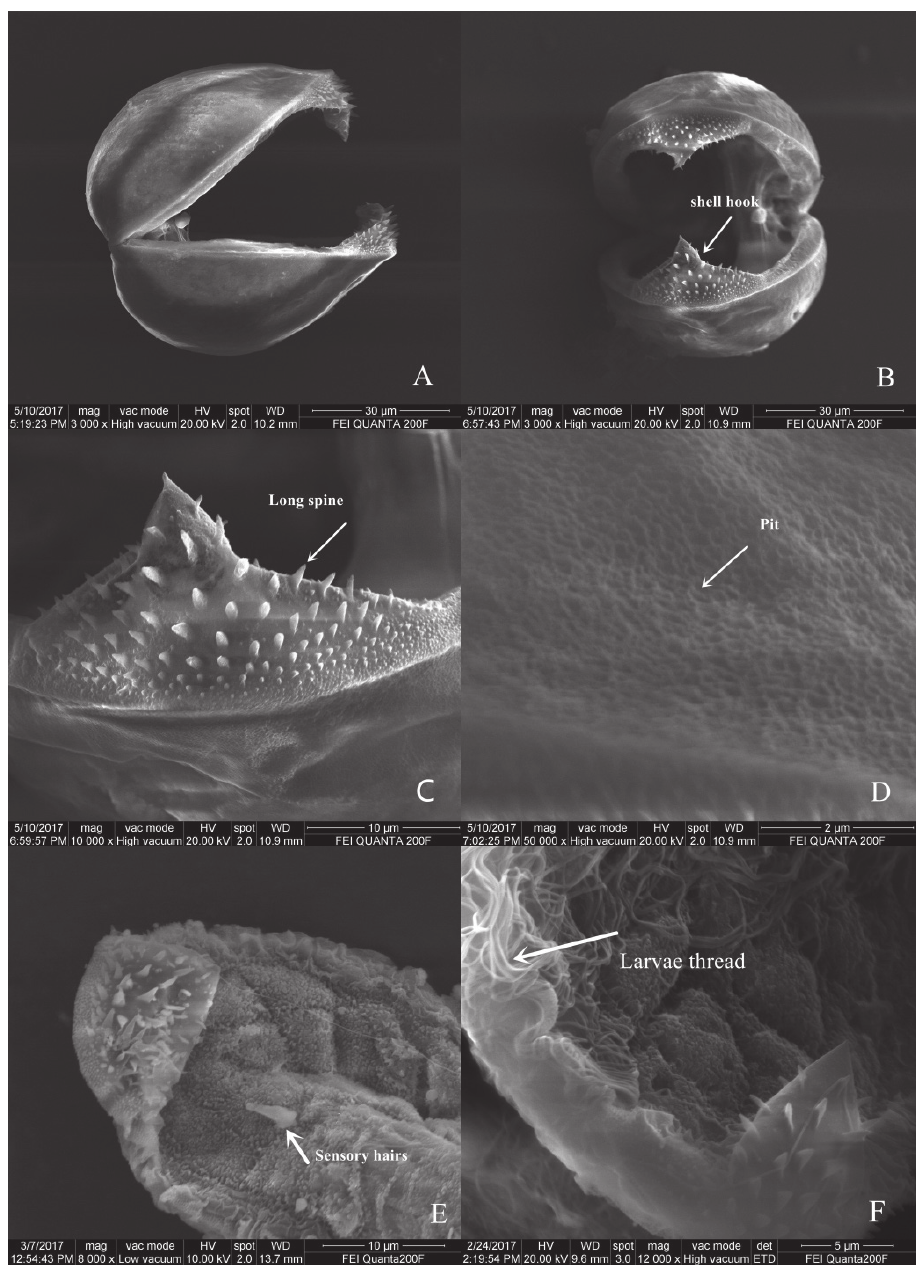
Figure 6. The morphology of glochidia of S. carinata ( A lateral B ventral valve C hook with large spines D the exterior valve sculpture E sensory hair tufts F the larvae